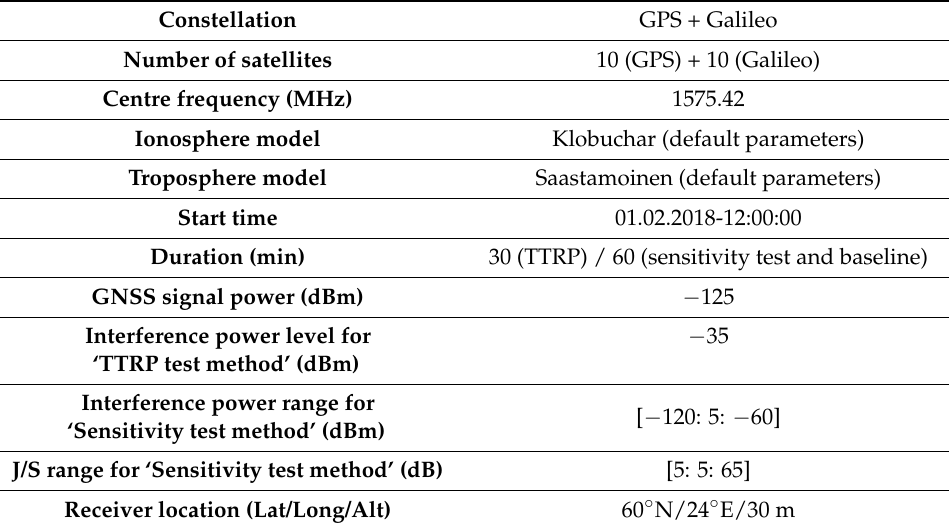
Table 1. Simulated scenario settings.